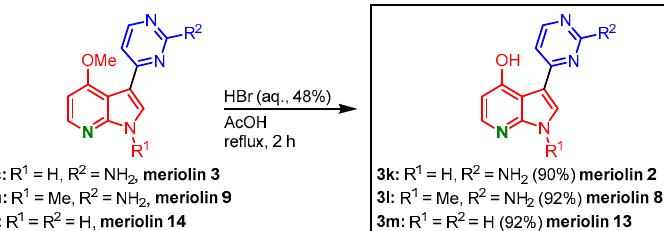
Figure 25. O -demethylation of meriolins 3, 9, and 14 gives 4-hydroxy-substituted meriolins 2, 8, and 13 [14].